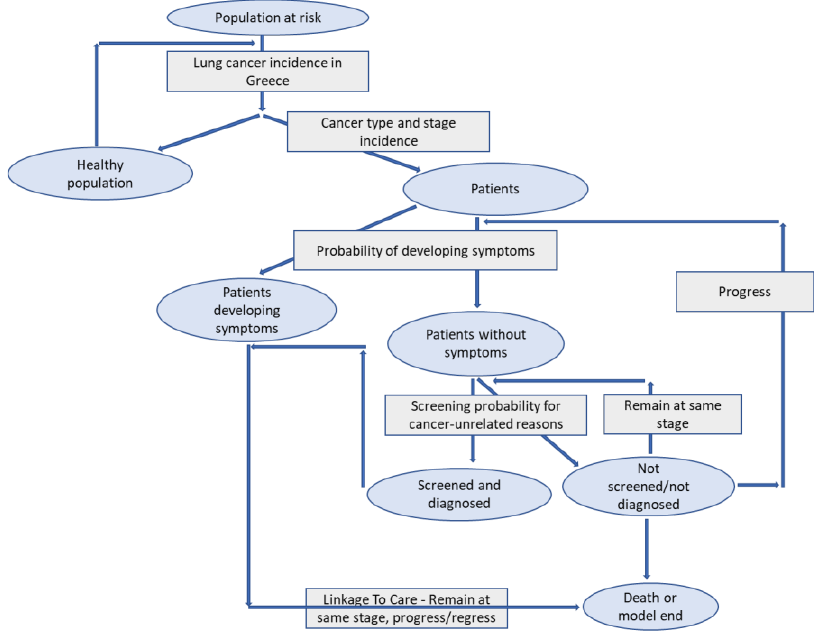
Figure 3. Model schema for the cohort population flow .